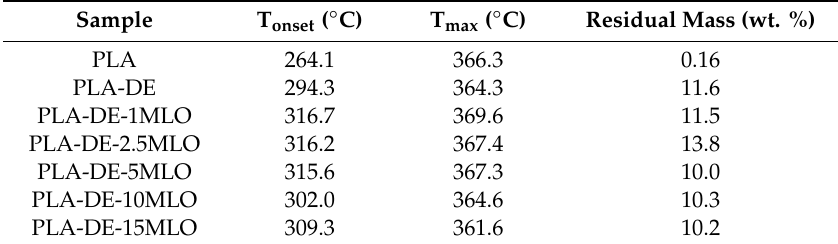
Table 4. Main thermal parameters of the thermal degradation of PLA / DE composites with varying MLO content obtained by thermogravimetric analysis,